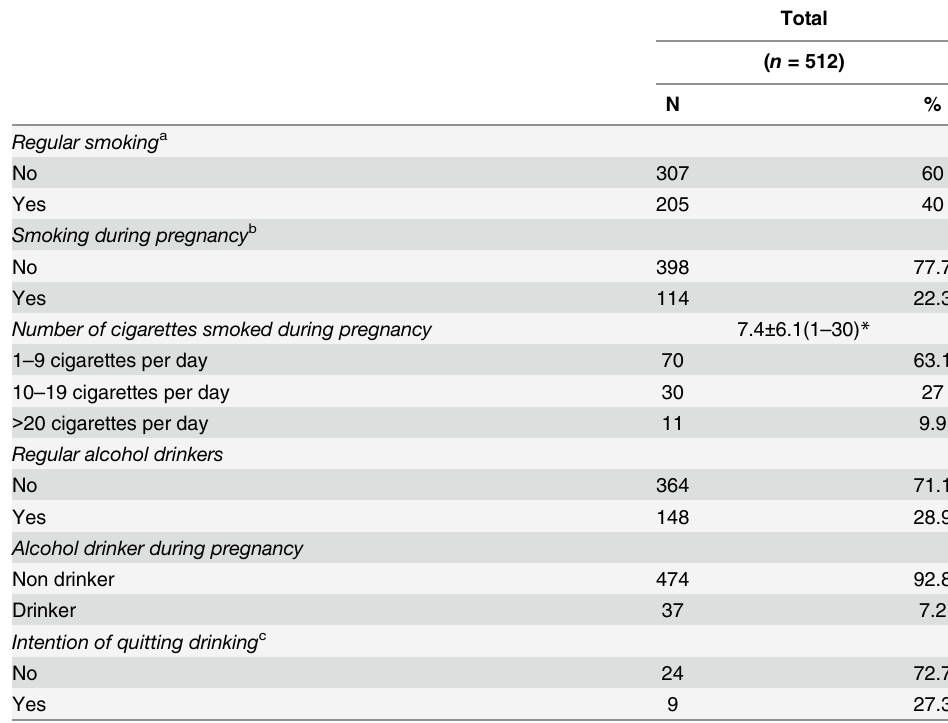
Table 3. Women ’ s attitudes and behaviors in